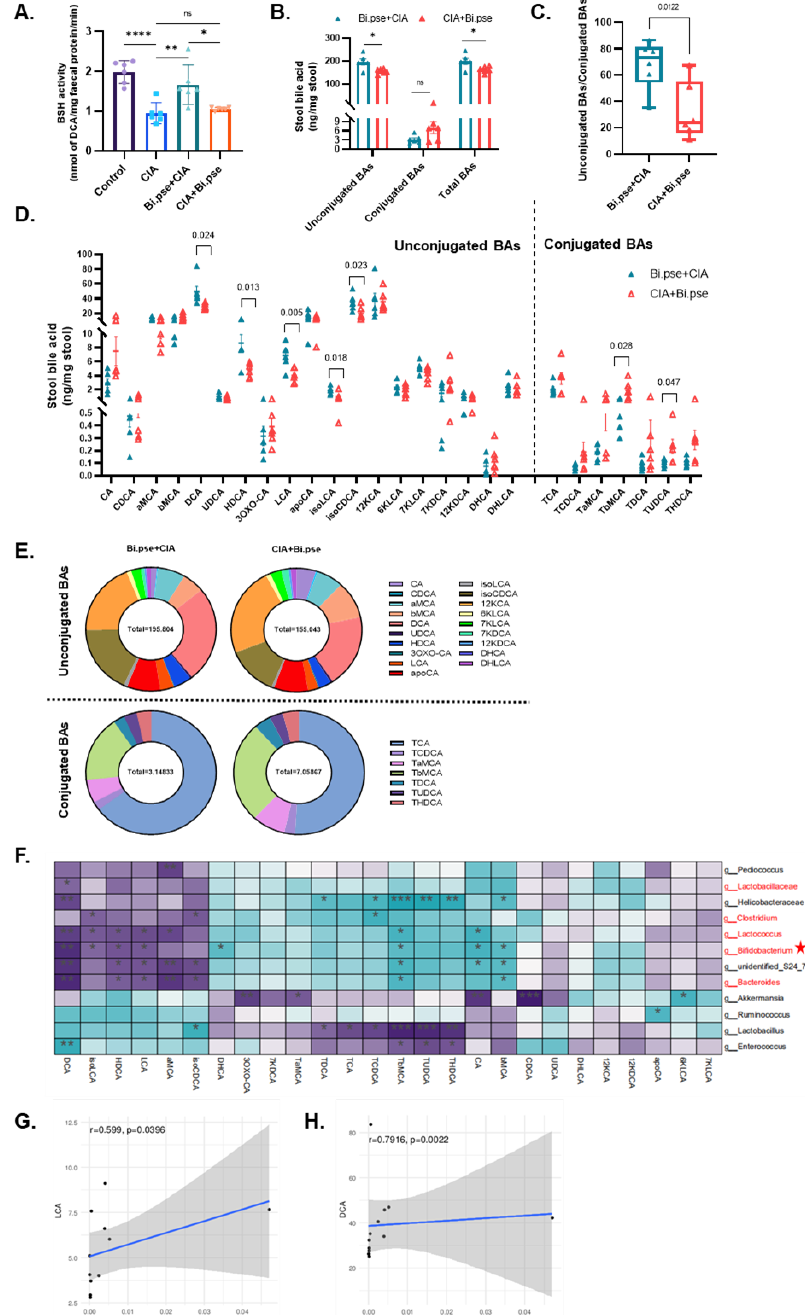
Figure 5. Upregulation of BSH activity and accumulation of unconjugated BAs in B. pseudocatenulatum prevention group. ( A ) A precipitation-based assay was established to measure fecal BSH activity. ( B , C ) Fecal unconjugated BAs, conjugated BAs, and the ratio of unconjugated to conjugated BAs compared between prevention and treatment groups. ( D ) BAs in feces were quantified using targeted metabolomics. ( E ) Fecal relative BA pool composition. ( F ) Heatmap showing positive ( purple ) and opposite ( blue ) correlation between BAs and the 12 genera. ( G , H ) Bifidobacterium spp. are strongly correlated with the expression levels of both DCA and LCA by using Spearman’s correlation coefficient. Red font indicates BSH-enriched genus. Values are presented as means ± SEM. One-way ANOVA and post-hoc Dunnett’s test were performed between multiple groups. Significant results are indicated as: ns: not significant, * p < 0.05, ** p < 0.01, *** p < 0.001, **** p <